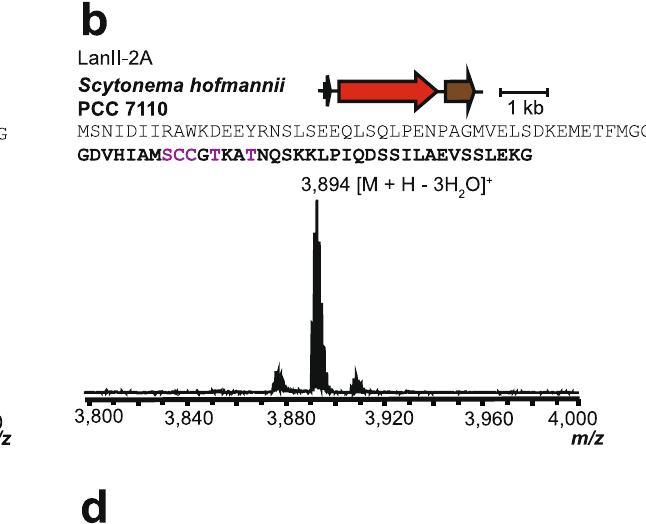
in purple, and MALDI-TOF mass spectrum of the modi fi ed peptide. Peptides were analyzed after protease digestion with endoproteinase AspN ( a , d ) LahT150 ( b ) or after in vivo production and extraction ( c ). RRE, RiPP recognition